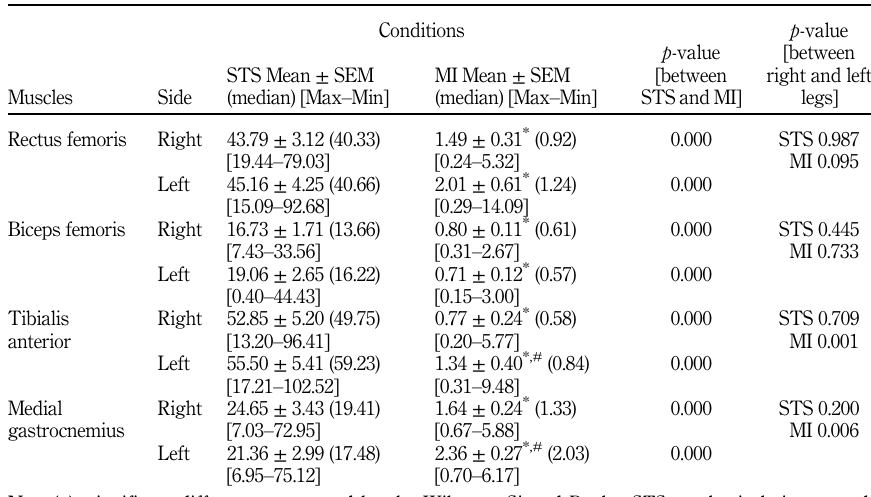
Table 3. Mean of duration of muscle activity during physical and imagined STS of four muscles of the right and left legs